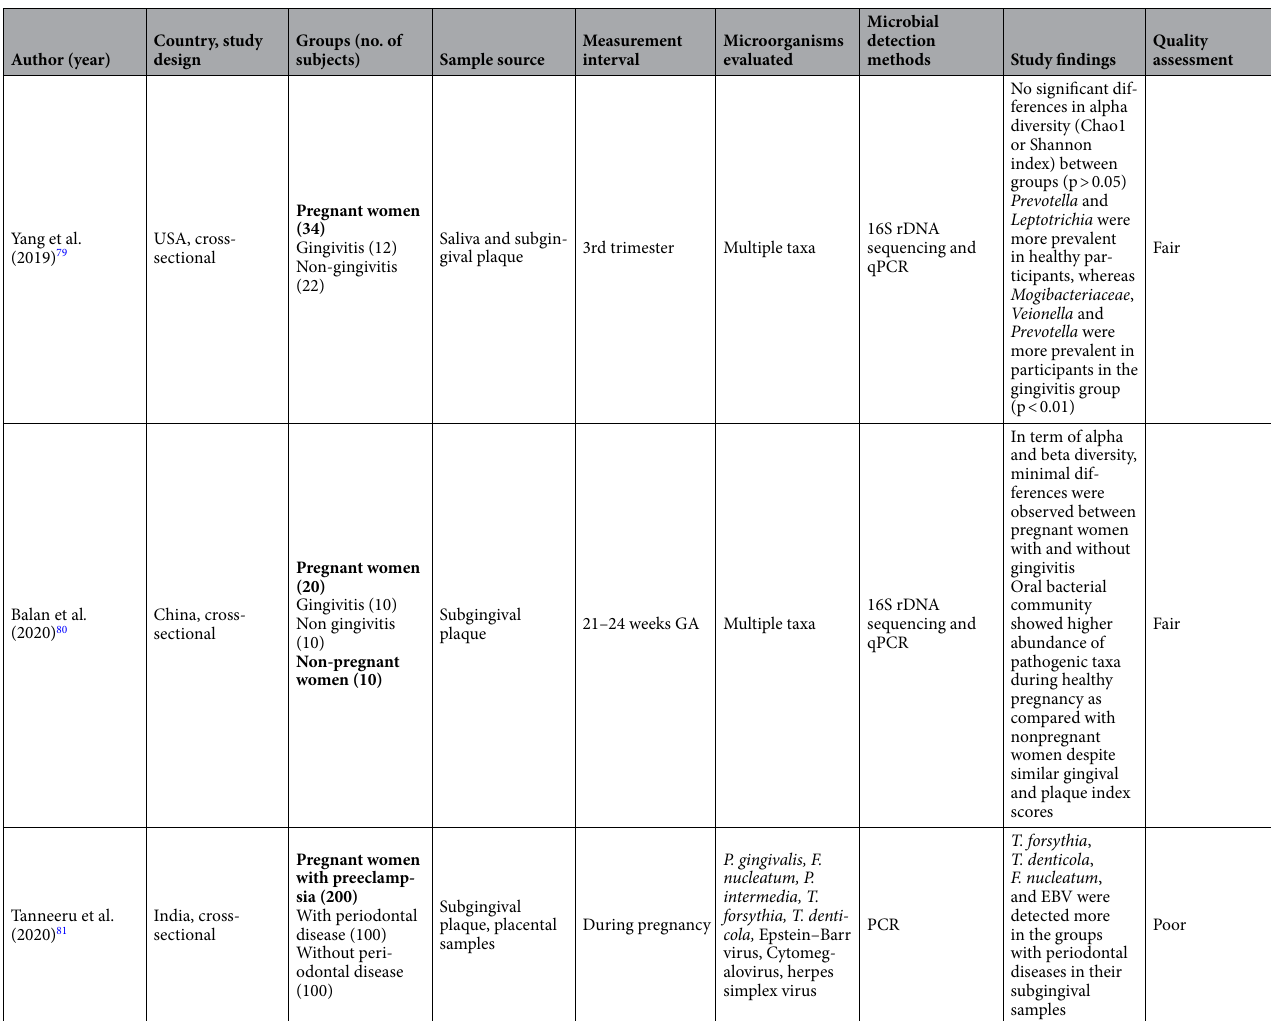
Table 5. Impact of periodontal disease on oral microorganisms during